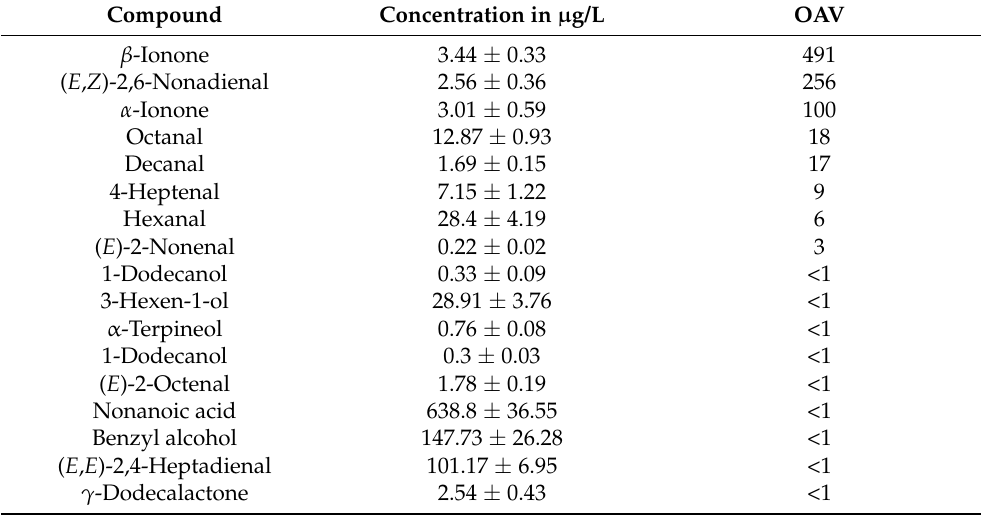
Table A6. Results of semi-quantification and calculated OAVs for sample 182.